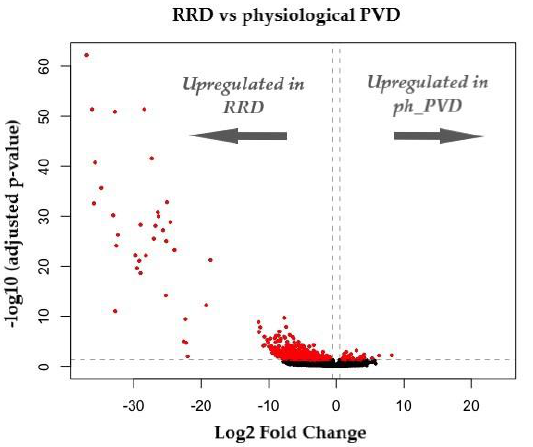
Figure 4. Volcano plot representing DEGs (differentially expressed genes) between RRD and phys- iological PVD. Log2 FC indicates the mean expression level for each gene. Each dot represents one gene. Red dots are indicative of statistically significant genes (adjusted p < 0.05) and log2FC < 0.5) (unpublished data).